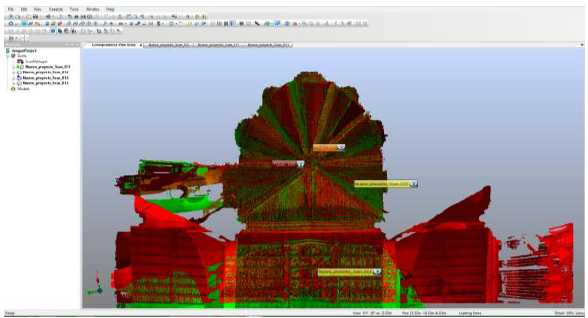
Figure 12. “Correspondence View” of registered scan data in FARO